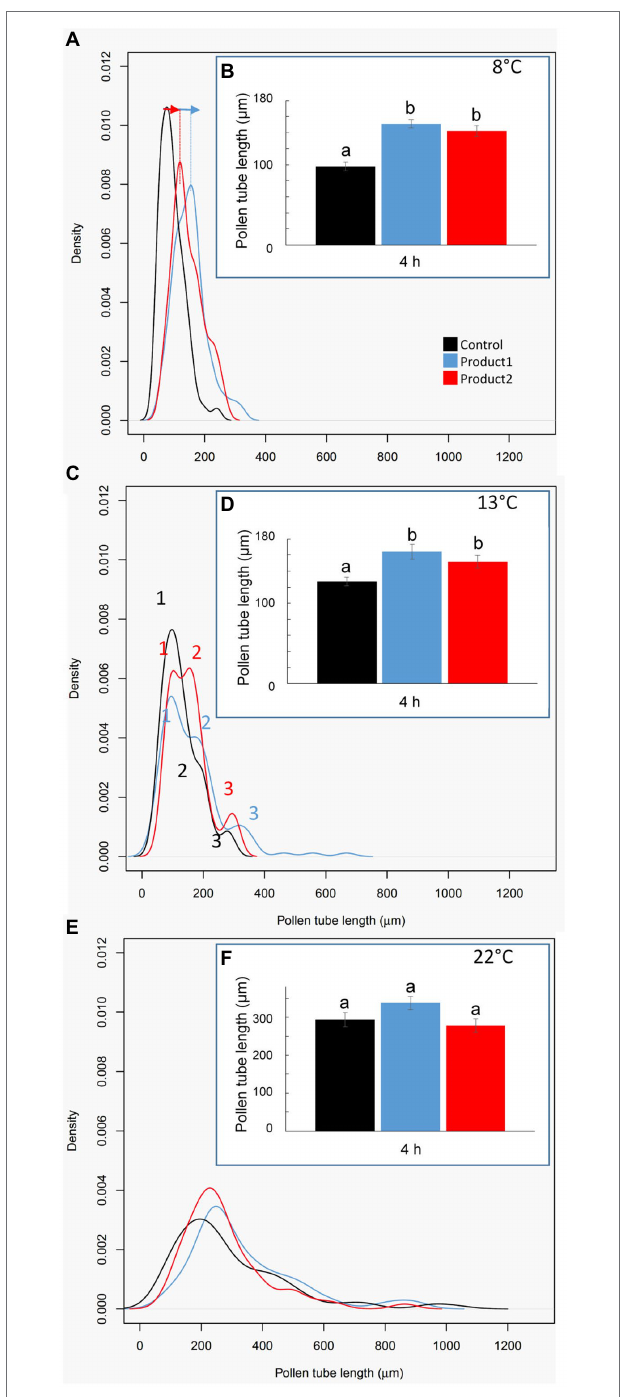
FIGURE 3 | Impact of temperatures and treatments on tomato pollen tube length. (A,C,E) Distribution plot of pollen tube length after 4 h of culture in the control condition (black line) or with 2 μ g.ml − 1 of P1 (blue line) or P2 (red line) at 8 (A) , 13 (C) , and 22 ° C (E) . (B,D,F) Pollen tube length after 4 h of culture in the control condition (black) or in a medium supplemented with 2 μ g.ml − 1 of P1 (blue) or P2 (red) at 8 (B) , 13 (D) , and 22 ° C (F) . Statistical analyses were carried out by one-way ANOVA and significant differences were analyzed by Dunnett’s multiple comparison test. Data are marked by different letters when significantly different to the control conditions at each temperature ( p <